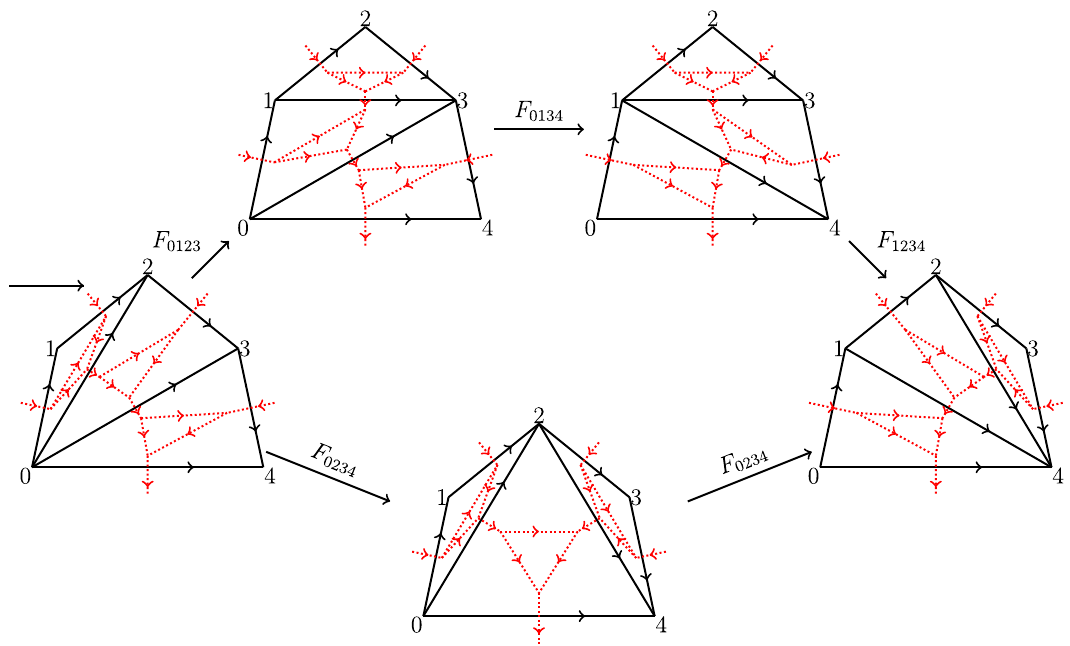
FIG. 11. Fermionic pentagon